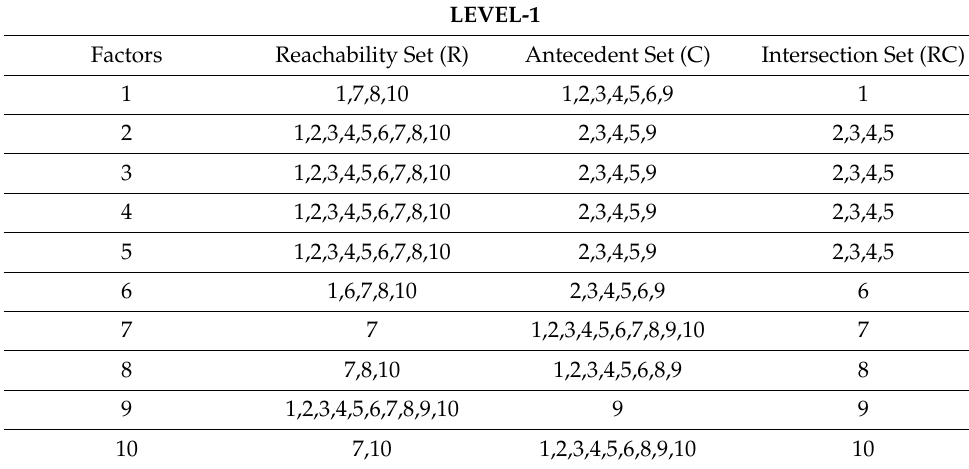
Table 5. Level of partition using ISM